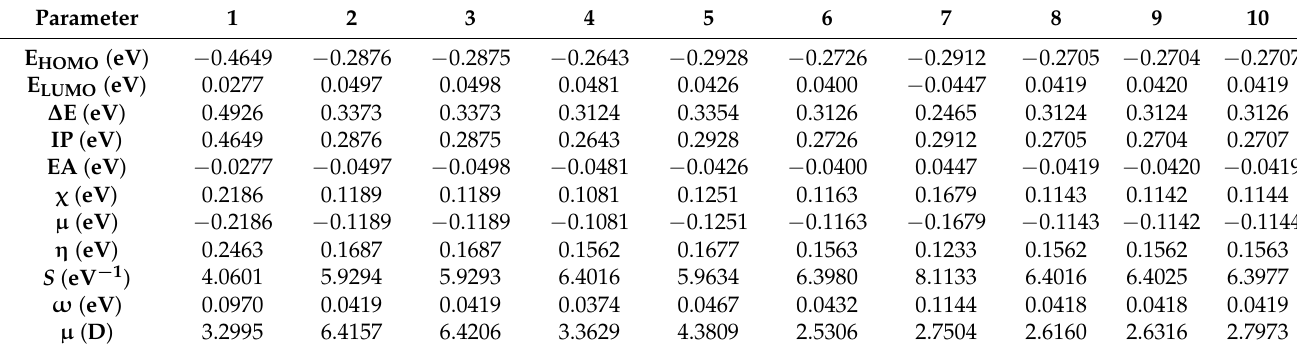
Table 5. Chemical descriptor parameters of disperse azo dyes 1 – 10 in gas